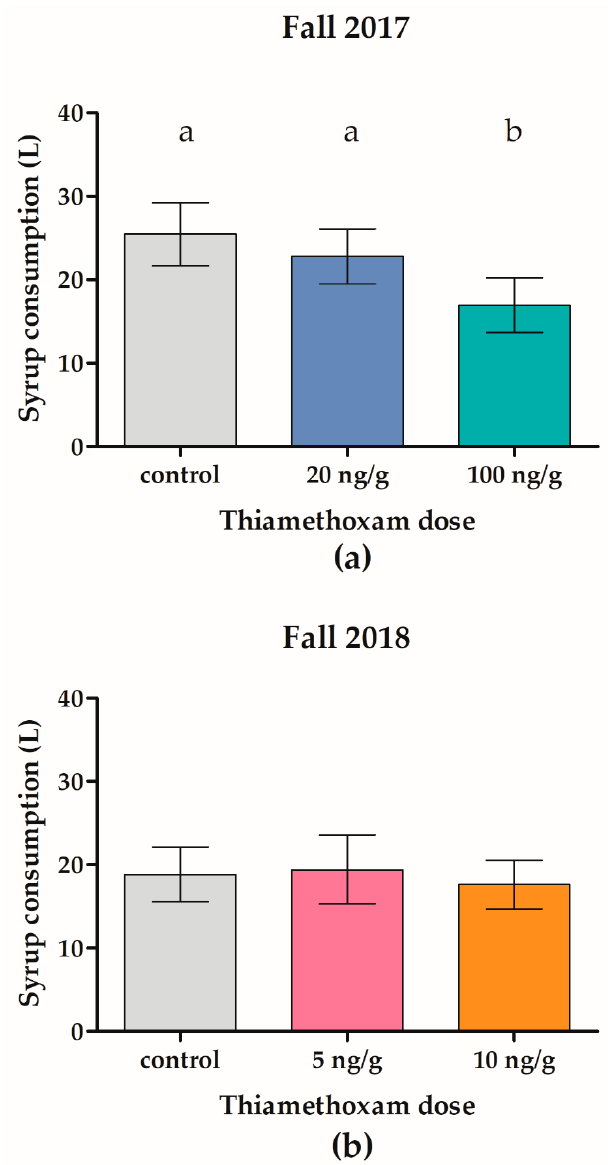
Figure 3. Chronic high-dose (100 ng / g) thiamethoxam significantly decreases cluster size of Apis mellifera colonies in the field. Honey bee colonies were exposed to thiamethoxam (THI) over winter in field trial 1 (2017–2018) ( a ) or field trial 2 (2018–2019) ( b ), and adult bee cluster size of the colonies was monitored in the fall and the following spring. Bars indicate mean ± SD interframe spaces occupied by the adult bee cluster for twenty to twenty-two colonies per group. Different letters indicate significant differences at each time point, p < 0.05 by ANOVA or Kruskal-Wallis rank test.